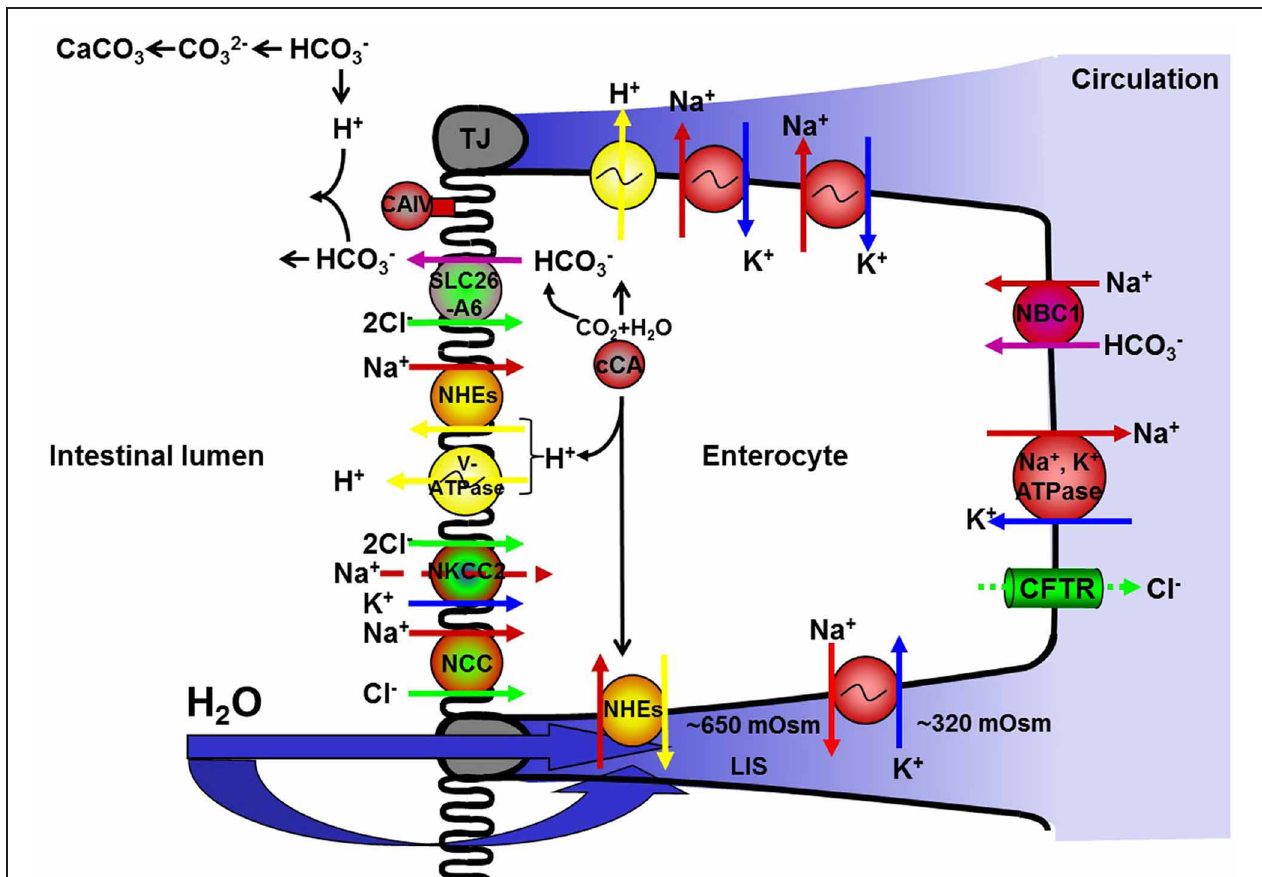
FIGURE 1 | A simplified version of the current hypothesis regarding ion- driven intestinal fluid absorption in stenohaline marine and seawater acclimated euryhaline teleosts (see text for details). NKA; Na + , K + -ATPase, NKCC; Na + :K + :2Cl − co-transporter, NCC; Na + :Cl − co-transporter,